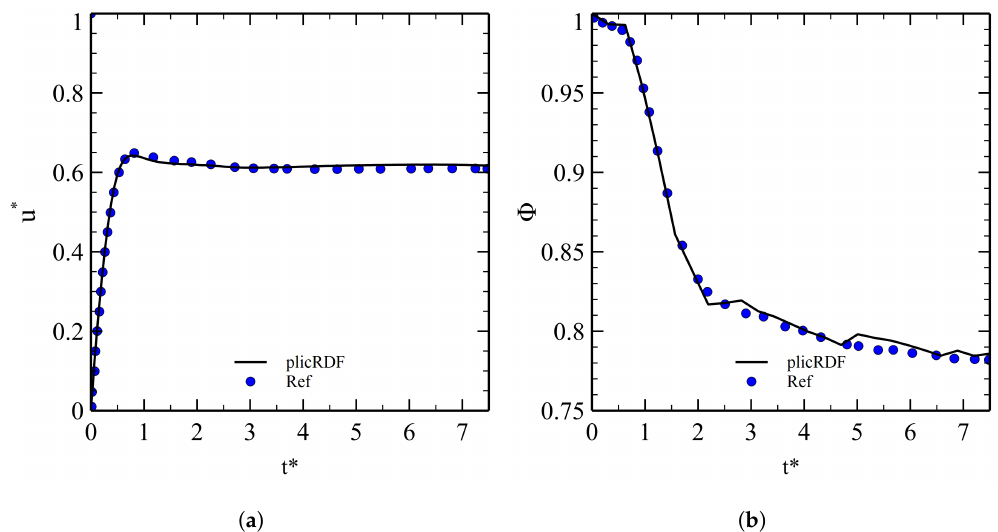
Figure 11. Evolution of u ∗ ( a ) and Φ ( b ) for the 3D C3 case provided by plicRDF compared with Ref. [10].